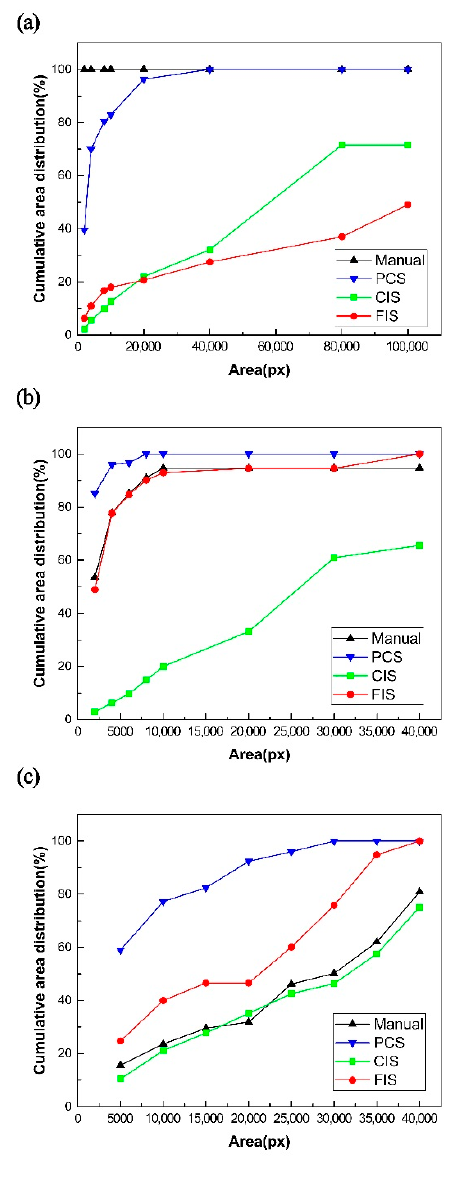
Figure 10. The results of raw images by segmenting group 1 using manual segmentation, PCS, CIS, and FIS, respectively: empty belt ( a ), mixed materials ( b ), and coarse materials ( c ).